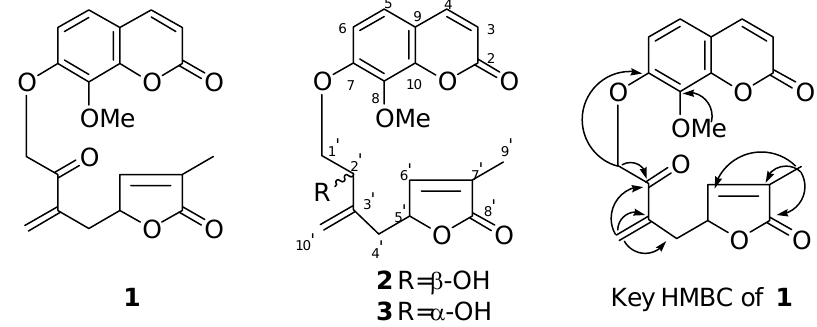
Figure 1. Structures of compounds 1 - 3 and key HMBC correlations of 1